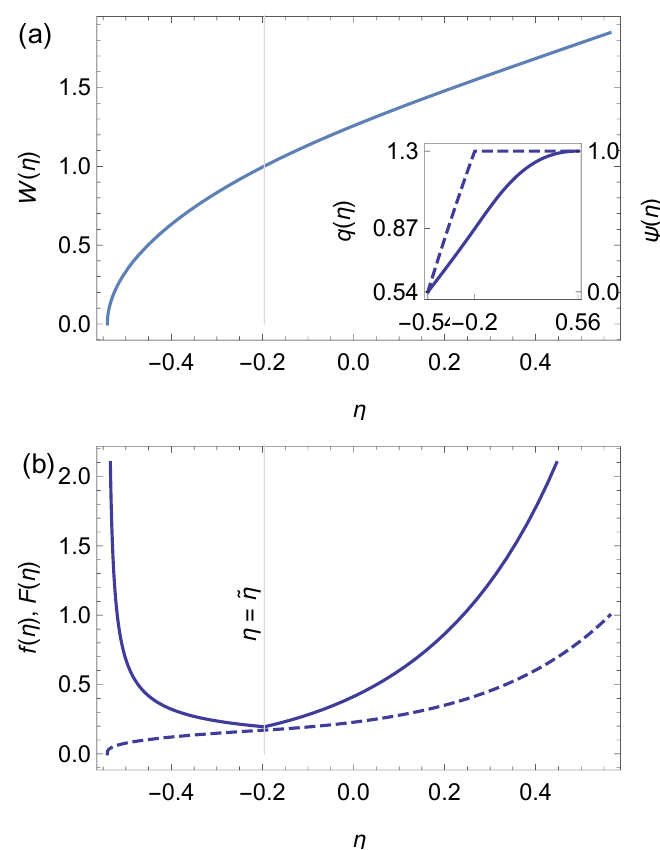
Figure 2. Solutions of the model of Section 4 with option to rent, using baseline parameters ρ = 0.06, r = 0.05, σ 1 = σ = 0.2, σ 2 = 0.0, a = 0.1, ¯ a = 0.04, δ = 0.02, θ = 15 and χ = 0.75. Contrast this to Figure 1 where identical parameters were used, but without renting. Subfigure ( a ): value function W , inset shows the functions q and ψ over the same η range; ( b ) the ergodic density f (solid curve) and the cumulative density function F (dashed). Notice the prominent peak in f towards the left-hand side